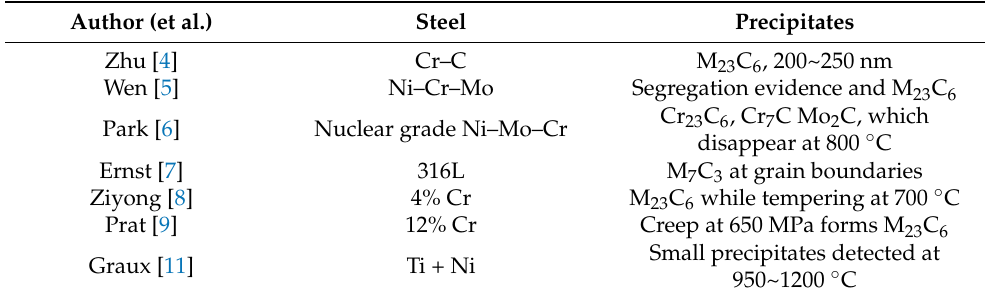
Table 1. Thermocalc simulations and characterization of different steels and precipitate formation at high